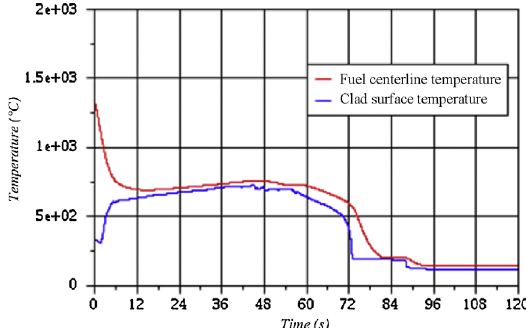
Fig. 15. Fuel centreline and clad surface temperatures at hot spot.